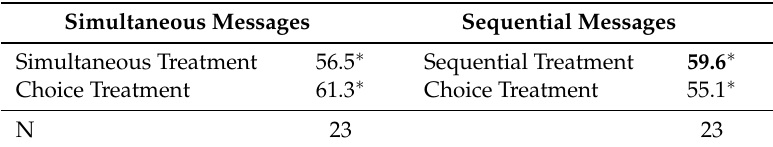
Table 5. Receiver Trust Frequency (%) a .